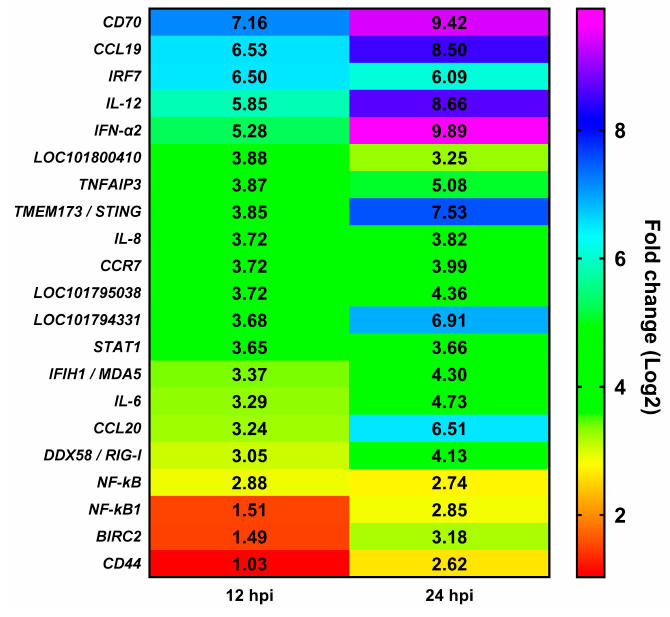
Figure 8. The top six differentially expressed genes in the Toll-like receptor signaling pathway, Chemokine signaling pathway, Nod-like receptor signaling pathway, Hematopoietic cell lineage, RIG-I-like receptor signaling pathway, and Cytosolic DNA-sensing signaling pathway. The colors in the grid represent the expression fold change as indicated by the color scale. Note: LOC101794331 (T-lymphocyte activation antigen CD86-like); LOC101795038 (fractalkine-like); LOC101800410 (T-cell surface glycoprotein CD1b-3-like).